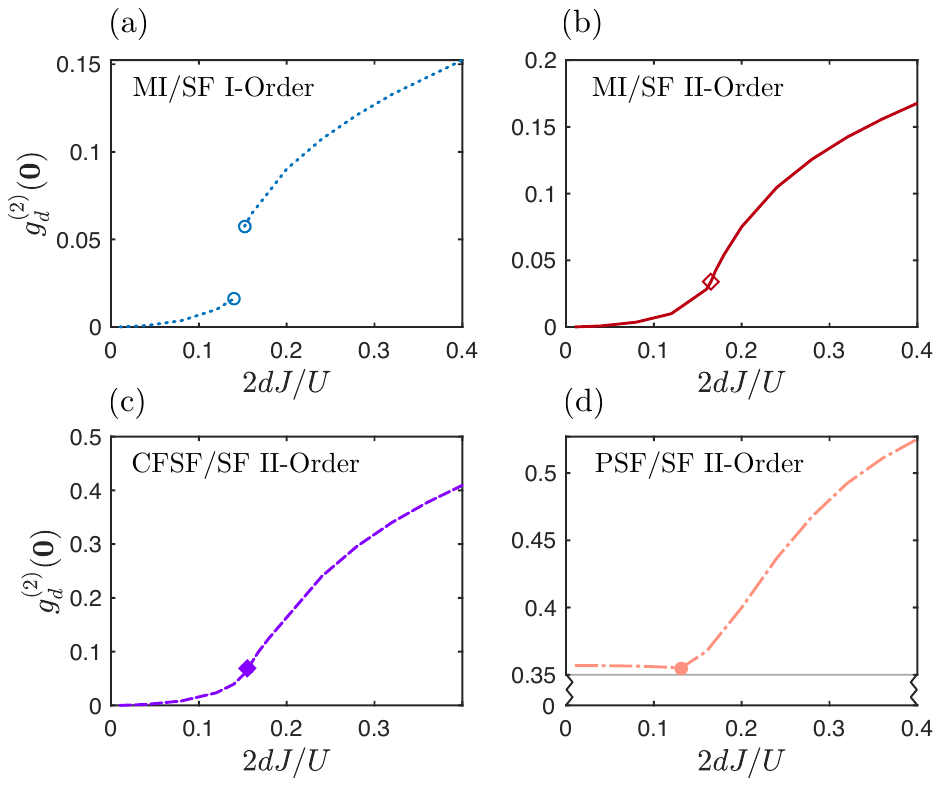
( 2 ) ( r = 0 ) evaluated for d = 2 as a Figure 15: Local density-density correlation g d function of 2 d J / U across (a) the first-order MI-to-SF edge transition (blue dotted / U = 0.9 and µ/ U = 1.4 at fixed n = 2, (b) the second-order MI-to-SF lines) for U d 12 / U = 0.5 and µ/ U = 1 at fixed n = 2, (c) edge transition (red solid line) for U d 12 / U = 0.9 the second-order CFSF-to-SF edge transition (purple dashed line) for U 12 = 1, and (d) the second-order PSF-to-SF transition (pink and µ/ U = 0.5 at fixed n d / U = − 0.7 and ( µ/ U ) = − 0.35 with n = 1.47. The dashed-dotted line) for U c d 12 point located on each curve indicates the location of the respective phase